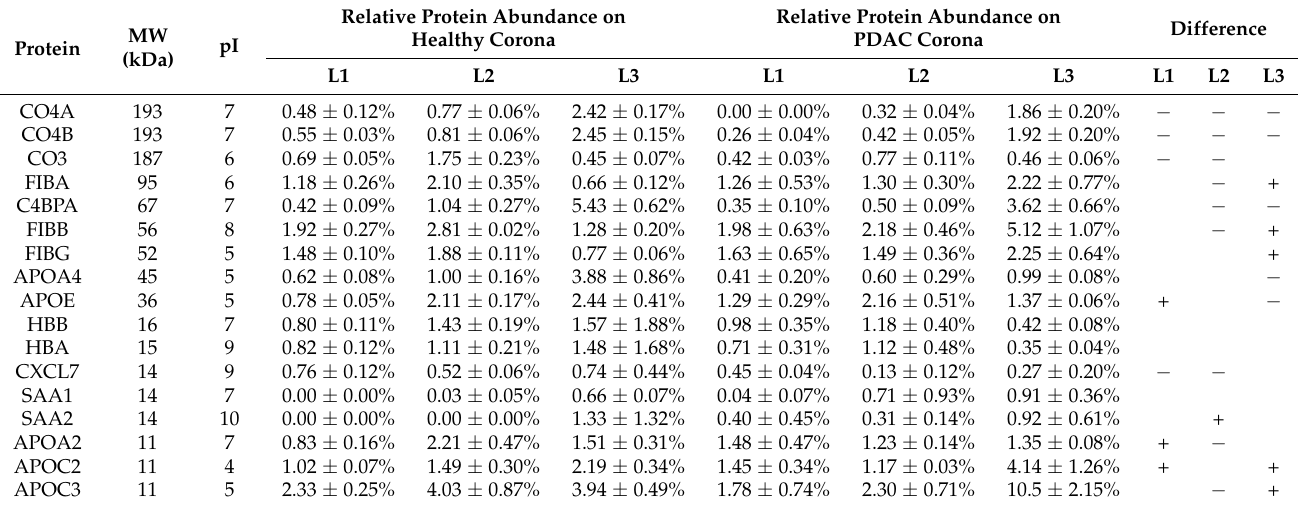
Table 3. Relative protein abundances (RPAs) of the most represented (RPA > 1%) proteins underlying the differences between PDAC and non-oncological